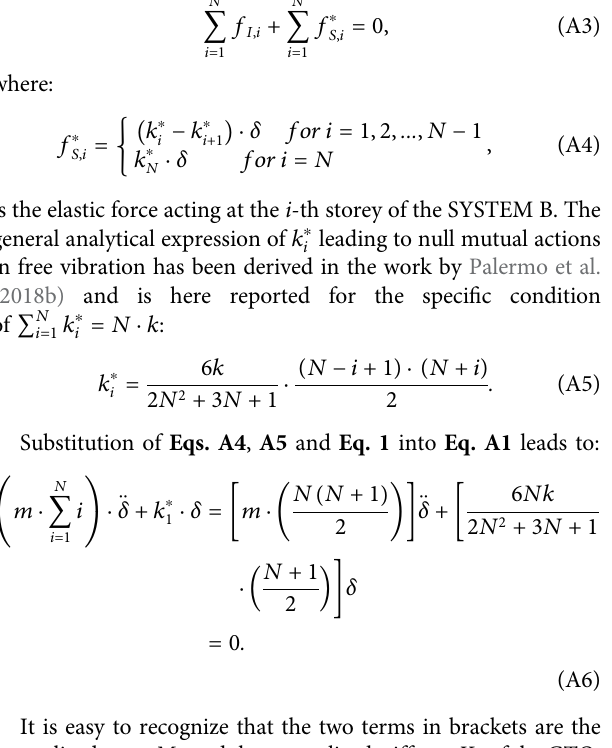
Table 1 of the work by Palermo et al.